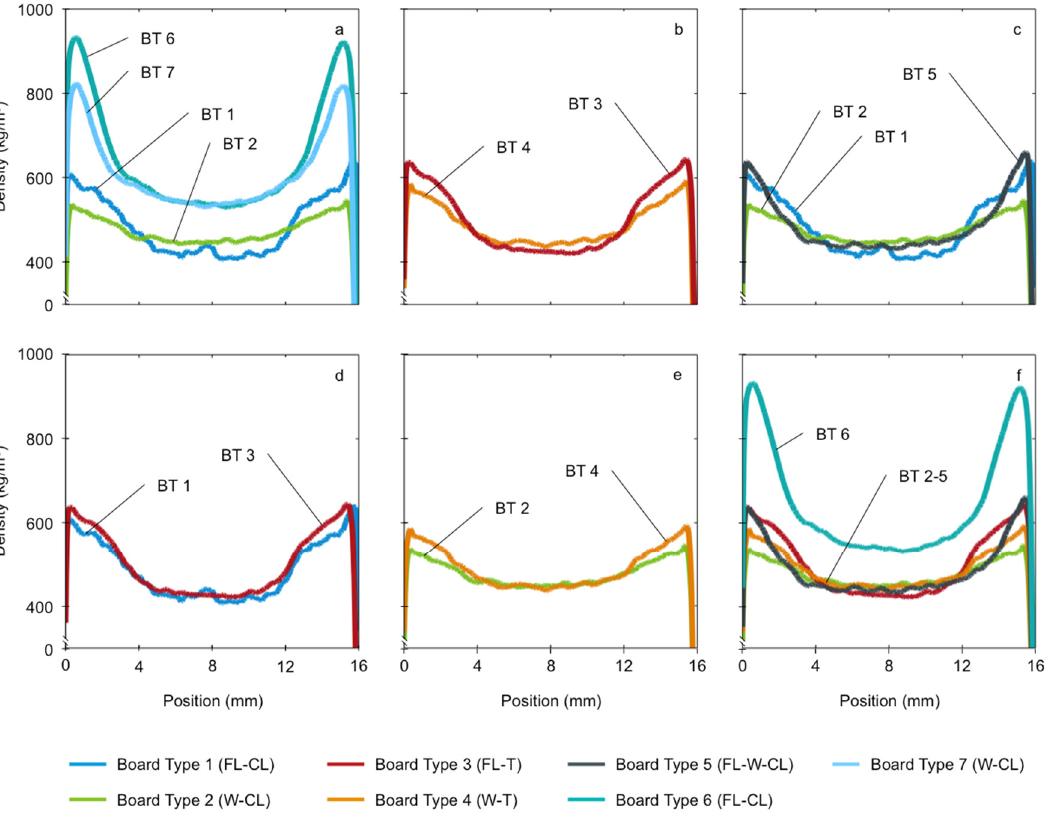
Figure 6. Average density profiles of the seven board types (BT 1–7) investigated, variously arranged ( a – f ). The scans were started at the board lower side (from pressing).